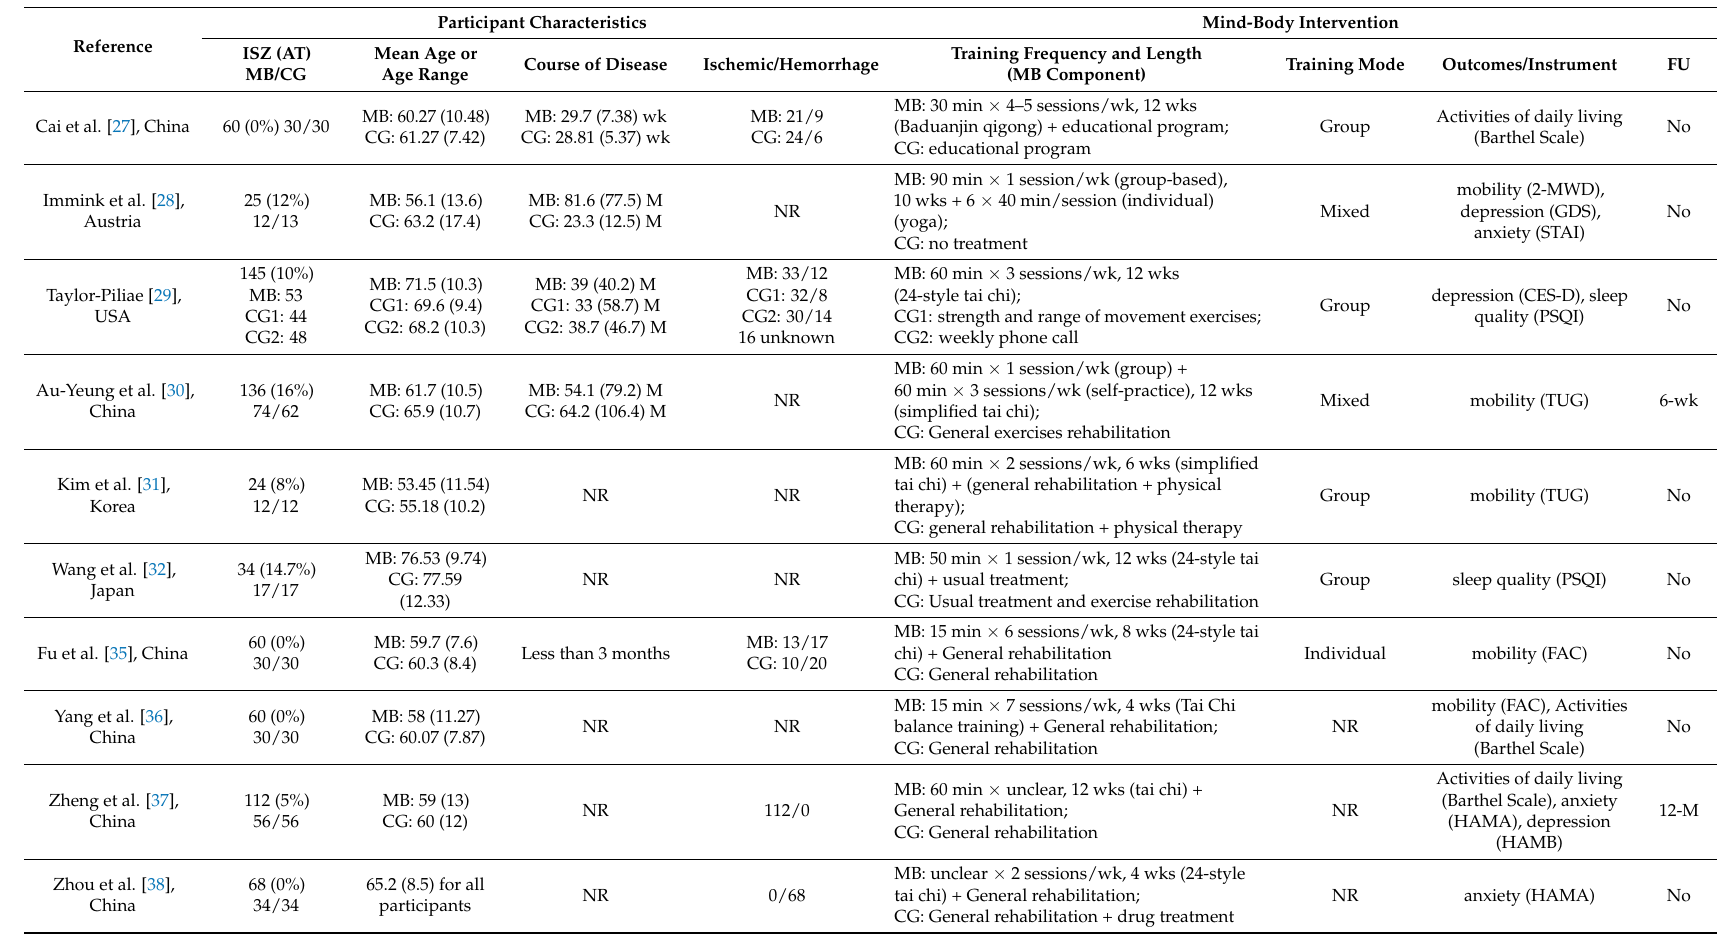
Table 1. Characteristics of studies selected in this systematic